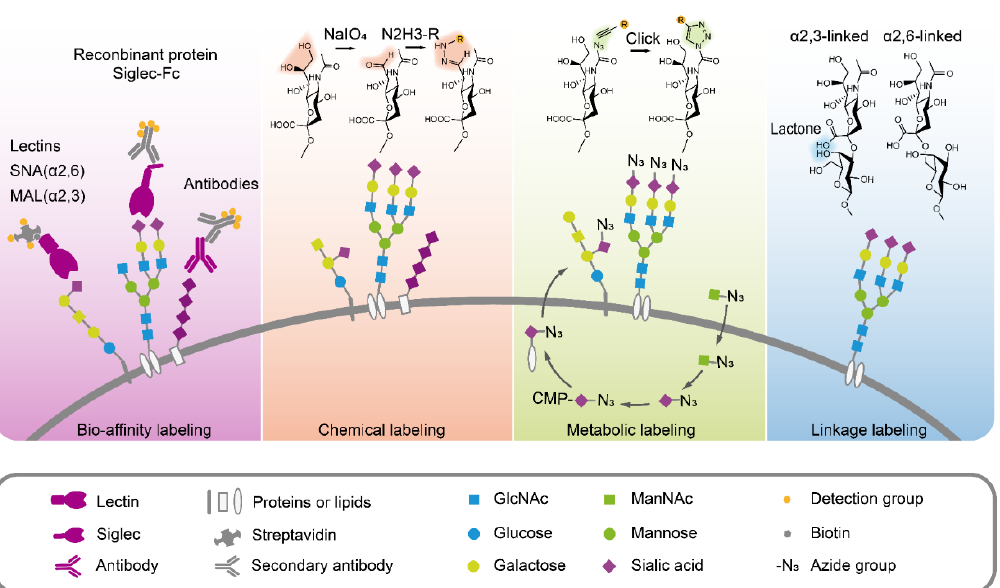
Figure 3. Different strategies for sialic acid analysis. Figure 3. Di ff erent strategies for sialic acid